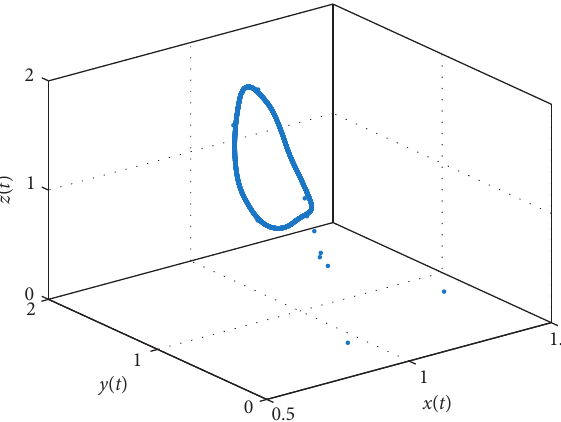
Figure 12: Strange attractors for α